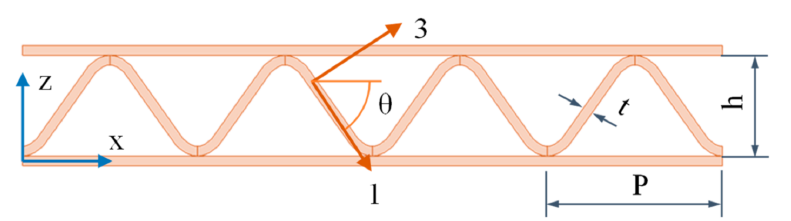
Figure 14. Corrugated lamina showing the laminate, xyz, and lamina, 123, reference frames. Reprinted with permission from ref. [12]. Copyright 2021